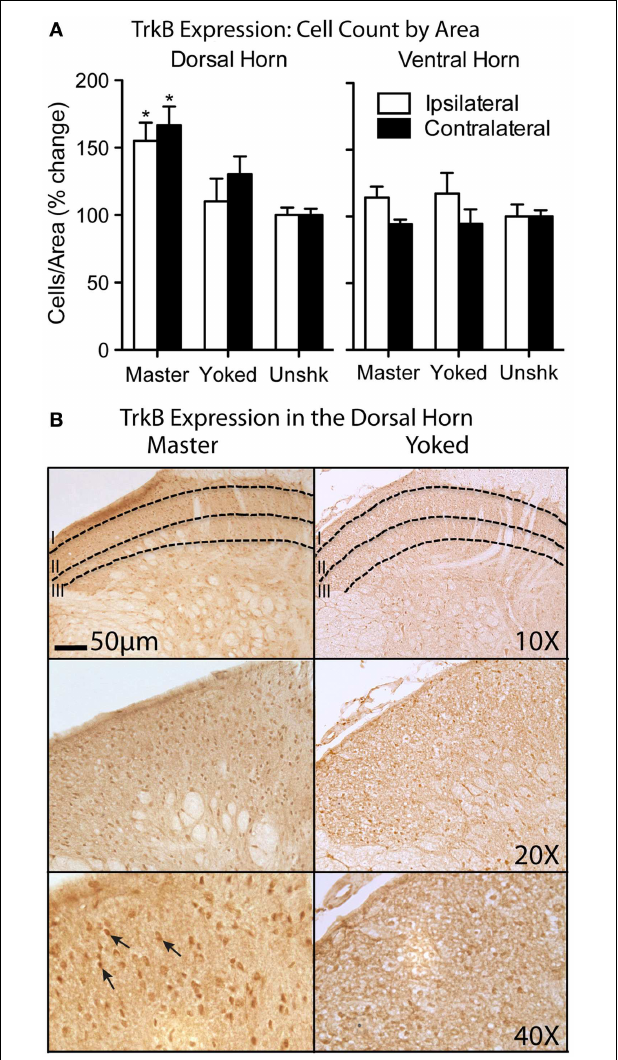
FIGURE 8 | Controllable shock increasesTrkB expression within the dorsal horn. (A) Number of cells labeled within the dorsal and ventral horn. Master rats exhibited greaterTrkB expression within dorsal horn on both the treated (shocked; ipsilateral) and untreated side (contralateral). No differences were observed within the ventral horn (* p < 0.05). (B) Light immunohistochemistry showed increasedTrkB immunolabeling in the dorsal horn of Master, but notYoked, rats. Adapted from Huie et al.